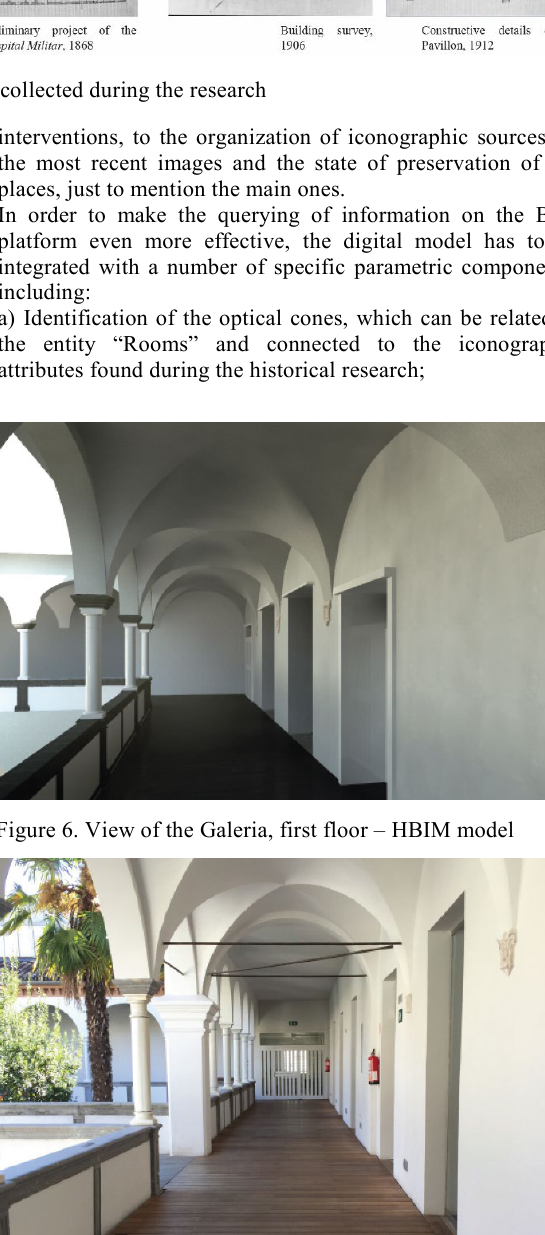
Figure 7. Photo of the Galeria, first